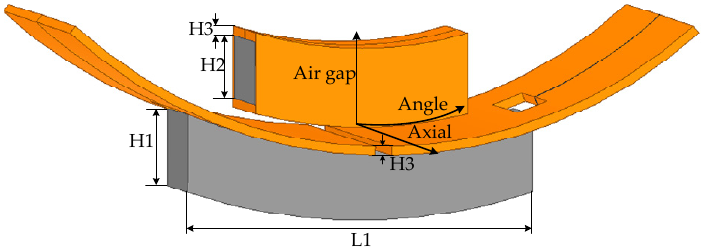
Figure 3. Schematic diagram of two structure sizes. ( a ) Arc-shaped core (Top view); ( b ) Double di- pole core (Front view).